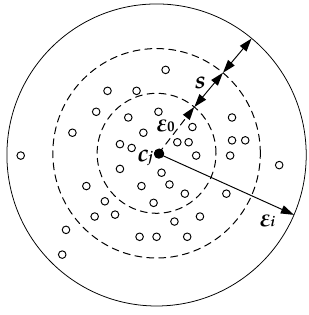
Figure 3. Calculating the neighborhood circles for high-density cell Step1: Build the buffer region for center c j by an increasing radius ε i = ε 0 + i*s , where the initial radius ε 0 and the step length s are both set as 10m and i denotes the iterative number. Step2: Count the ratio of trajectory points in two adjacent buffer regions as formula (3), where Num (ε i ) is the number of trajectory points falling in the